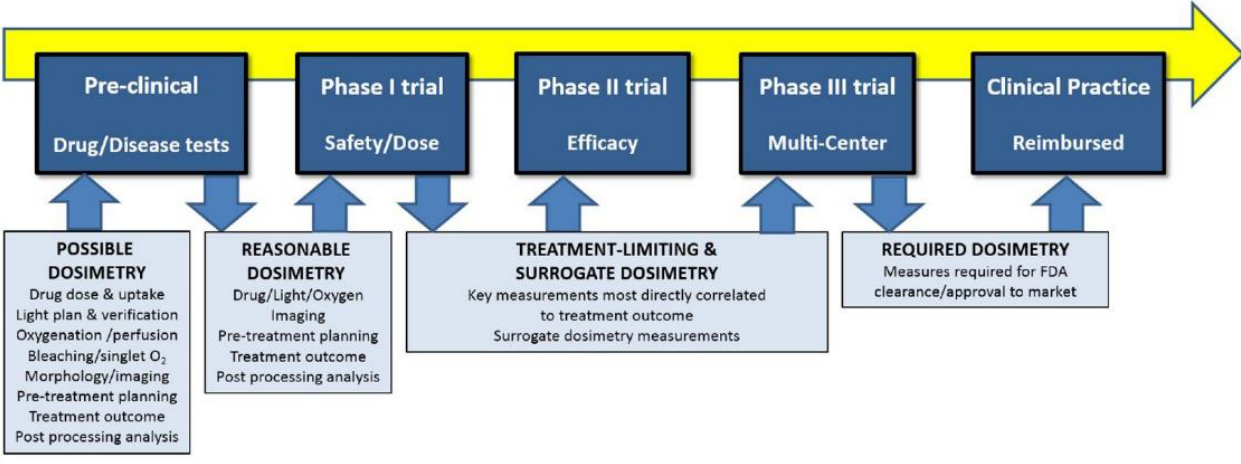
Figure 7. The shift from preclinical evaluation, through Phase I, II, and III clinical trials, and finally to accepted clinical practice is illustrated, with the advocated shifts in dosimetry goals throughout the pathway. While a comprehensive dosimetry approach might be used in preclinical work to mechanistically inform practice, the transition to Phase I trial requires that reasonably efficient methods of dosimetry be implemented, and in the future, the goal should be to shift towards treatment-limiting dosimetry and correlated surrogates. Eventually, these might become the required dosimetry in approved/cleared treatments, going beyond basic prescriptions of light and drug doses. The image and caption are reproduced from their original created by Pogue, B.W. et al., Phys. Med. Biol. 2016, 61, R57–R89 (doi:10.1088/0031- 9155/61/7/R57) [194] under Creative Commons Attribution 3.0.